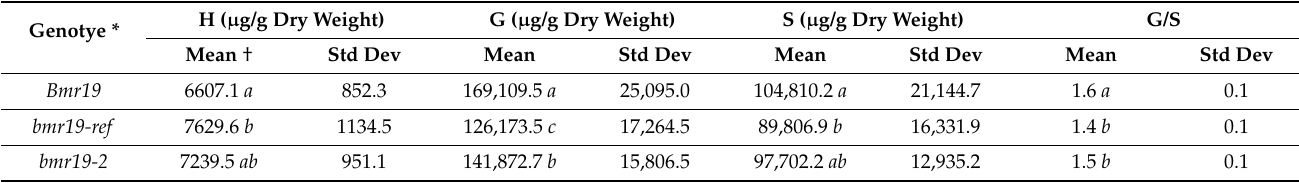
Table 5. Lignin monomer [ p -hydroxyphenyl (H), syringyl (S), guaiacyl (G)] yield by thioacidolysis of field grown biomass from BTx623 and